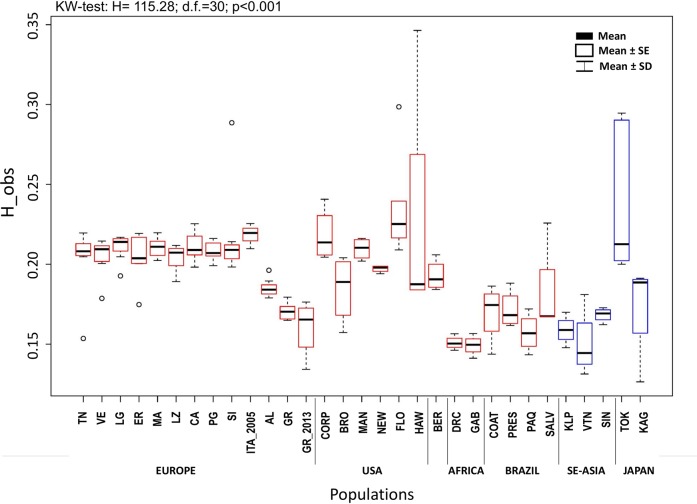
Individual observed heterozygosity averaged per population as estimated using vcftools for the global dataset of 38,550 SNPs.The mean, the standard deviation (SD), and the standard error (SE) are presented for each bar plot; dots represent outliers. The results for the non-parametric Kruskal-Wallis test, implemented to test for differences between the populations at a worldwide scale, are given above the graph. Color code: blue = native range; red = invasive range. Populations codes as in Table 1.